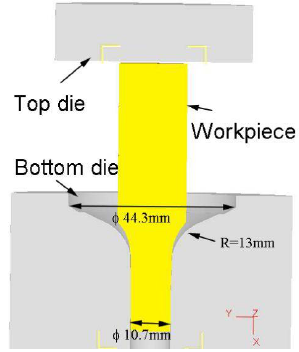
Figure 6. FE model for forging simulation. Table 4. Parameters for hot forging simulation.